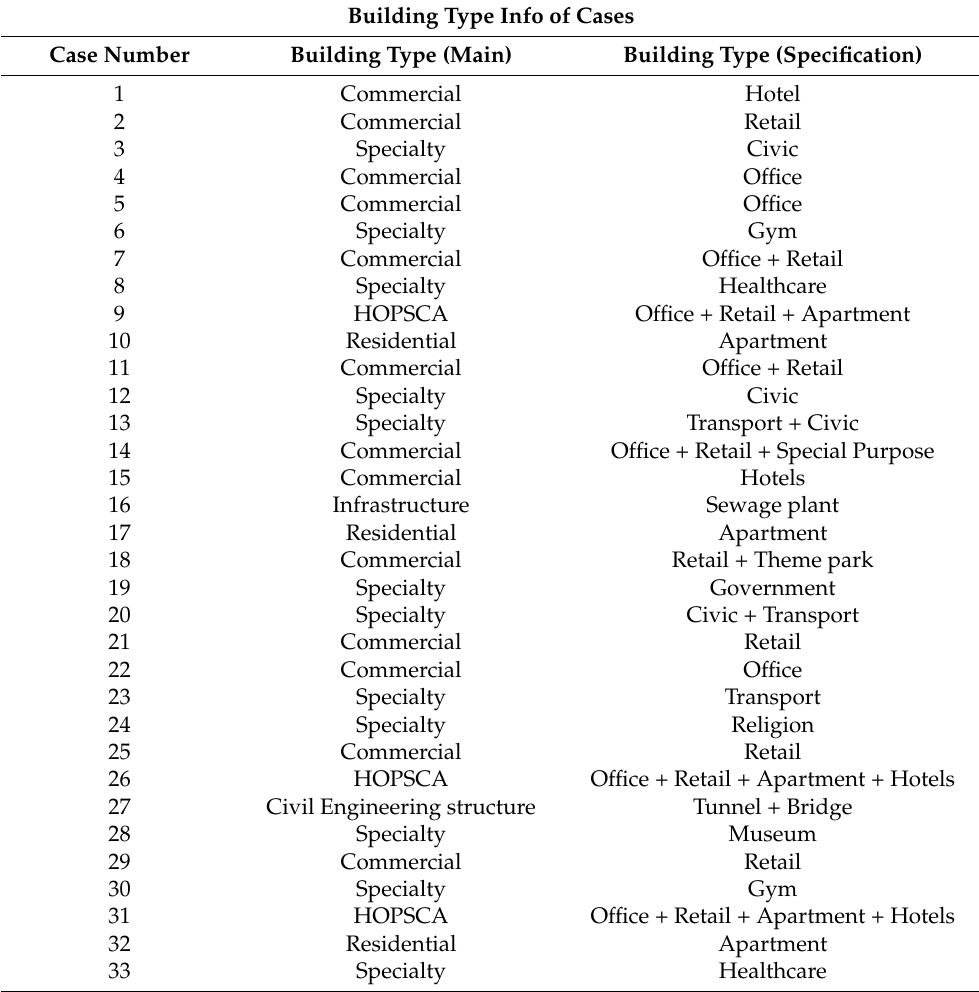
Table 6. Building type information of